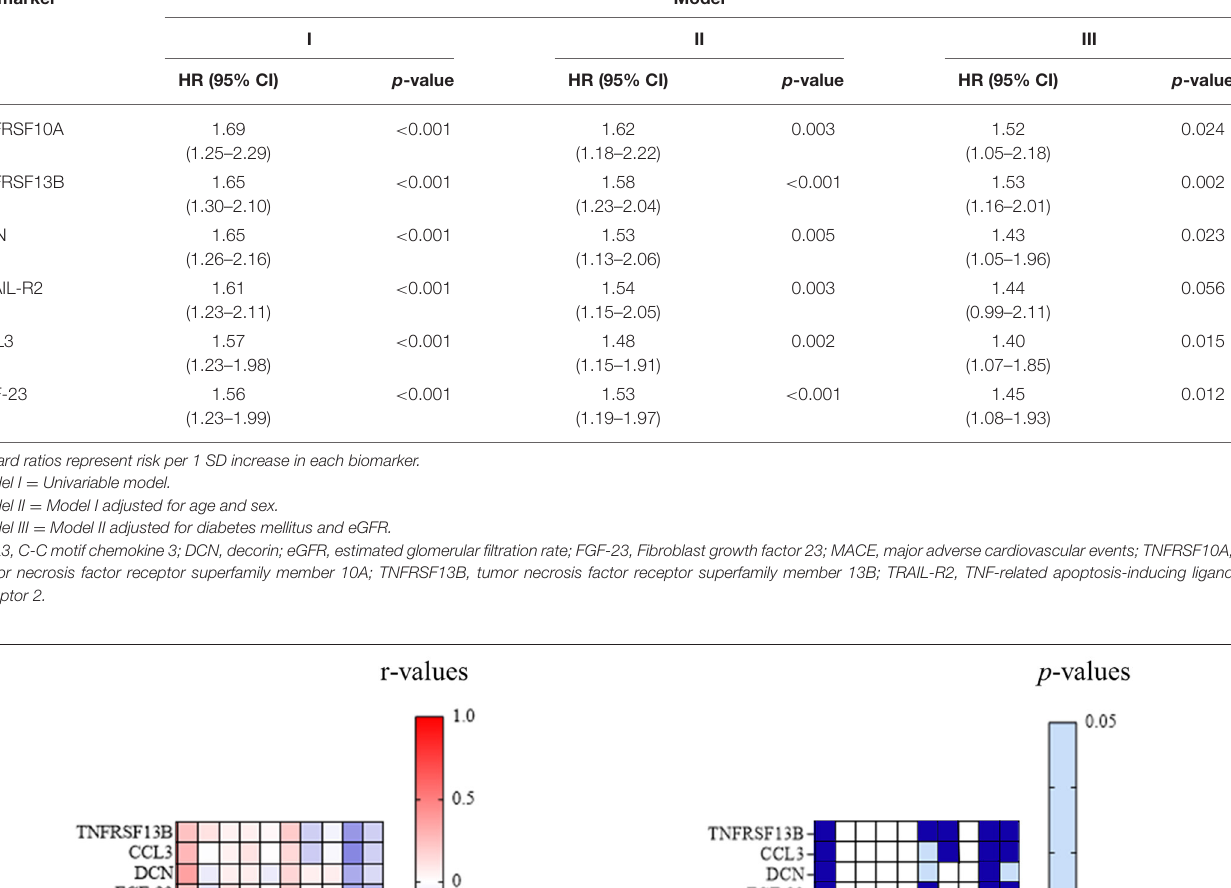
increased risk of death or recurrent myocardial infarction